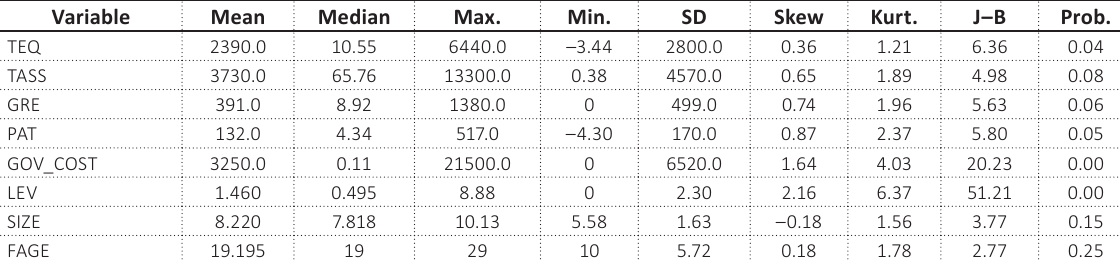
Table 4. Descriptive statistics for investment companies